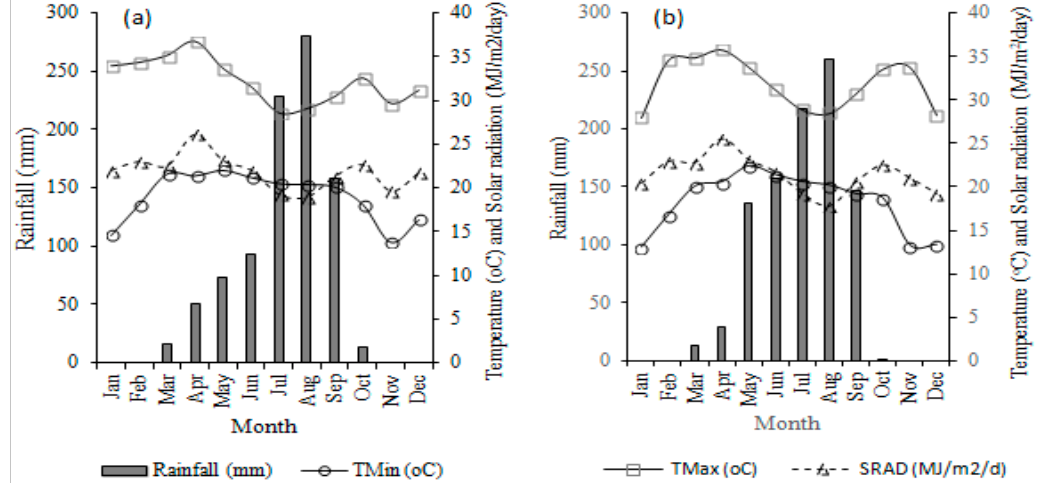
Figure 2. Monthly rainfall, temperature and solar radiation at Zaria for 2015 ( a ) and 2016 ( b ) experimental year.